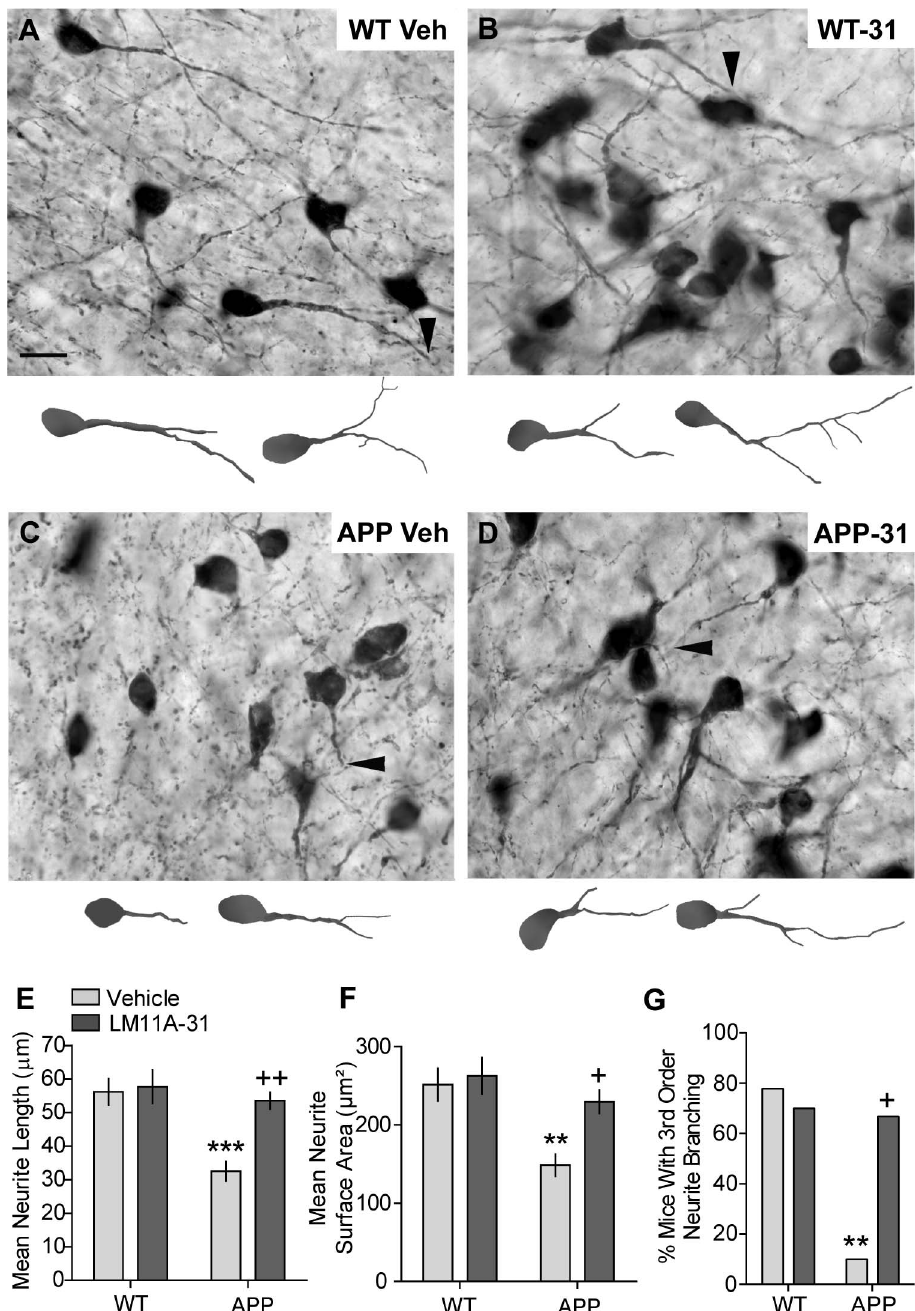
Figure 5. LM11A-31 prevents and/or reverses basal forebrain cholinergic neurite atrophy in mid-stage APP L/S mice. Representative photomicrographs show ChAT-immunostained neurons in VDB of the basal forebrain of ( A ) WT Veh, ( B ) WT LM11A-31 (-31), ( C ) APP L/S (APP) Veh, and ( D ) APP-31 mice at 9–11 months of age. Arrowheads indicate the distal part of neurites. Below each photomicrograph are reconstructed drawings from Neurolucida tracings of two ChAT-stained neurons per treatment group. The left drawing is the neurite and corresponding soma indicated by the arrowhead in the photomicrograph (orientations were altered). The right drawing is of a cell outside the field displayed in the photomicrograph but within the field analyzed. Scale bar in A=20 m m and also applies to the line drawings. Quantification indicates that treating APP L/S mice with LM11A-31 for 3 months increases the ( E ) length, ( F ) area occupied by, and ( G ) branching of BFCN neurites compared to those given vehicle. Statistical significance was determined using an ANOVA with Dunnett’s post-hoc test and, for branching, a 2 6 2 contingency table with Fisher’s exact test (WT Veh, n=9 mice; WT-31, n=10; APP Veh, n=10; APP-31, n=9). ** p # 0.01 and *** p , 0.001 vs. WT Veh; + p # 0.05 and ++ p # 0.01 vs. APP Veh.